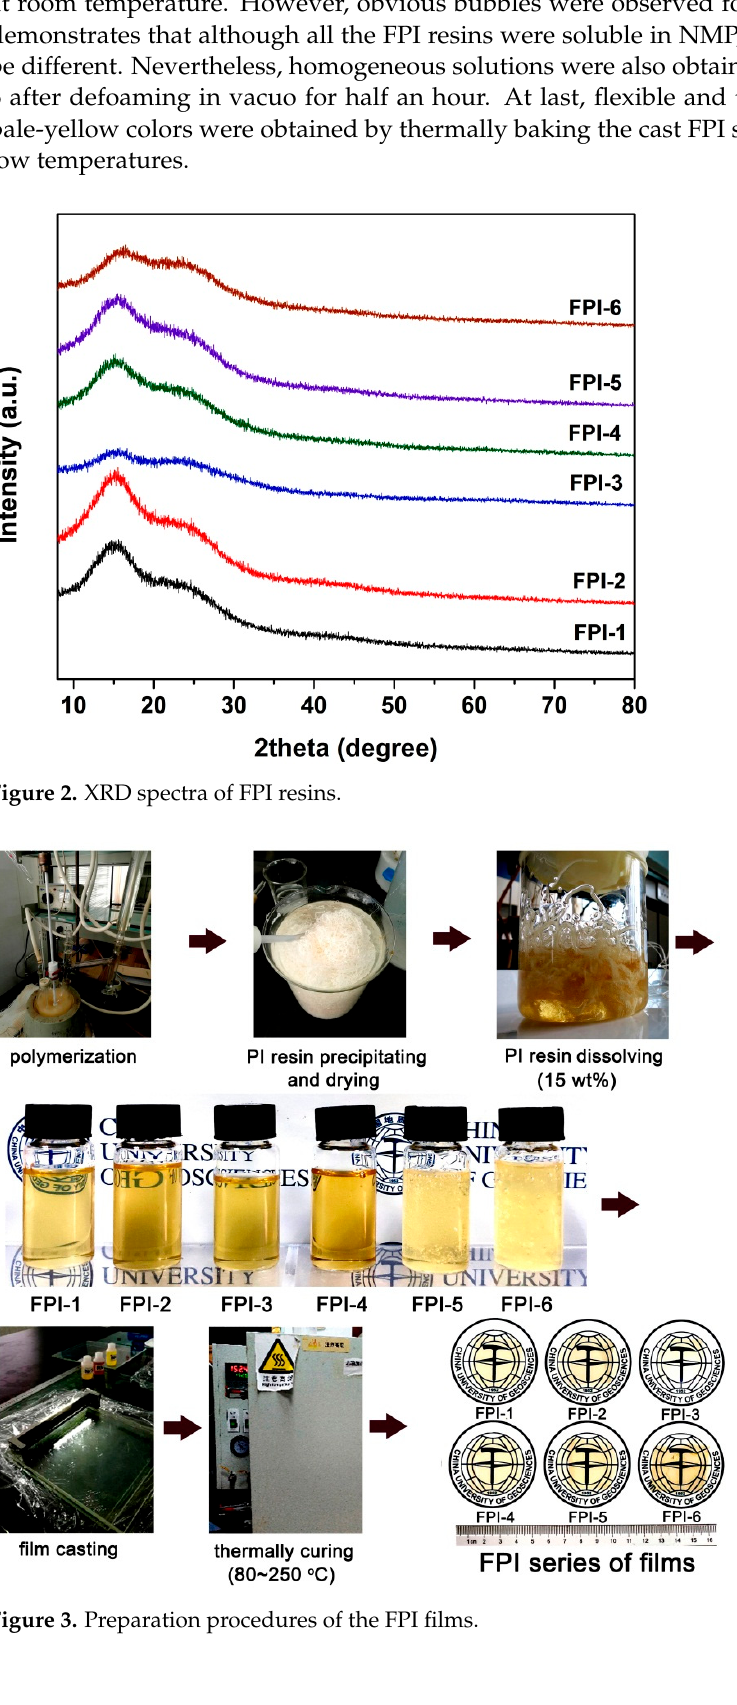
Table 2. Molecular weights and solubility of FPI resins.